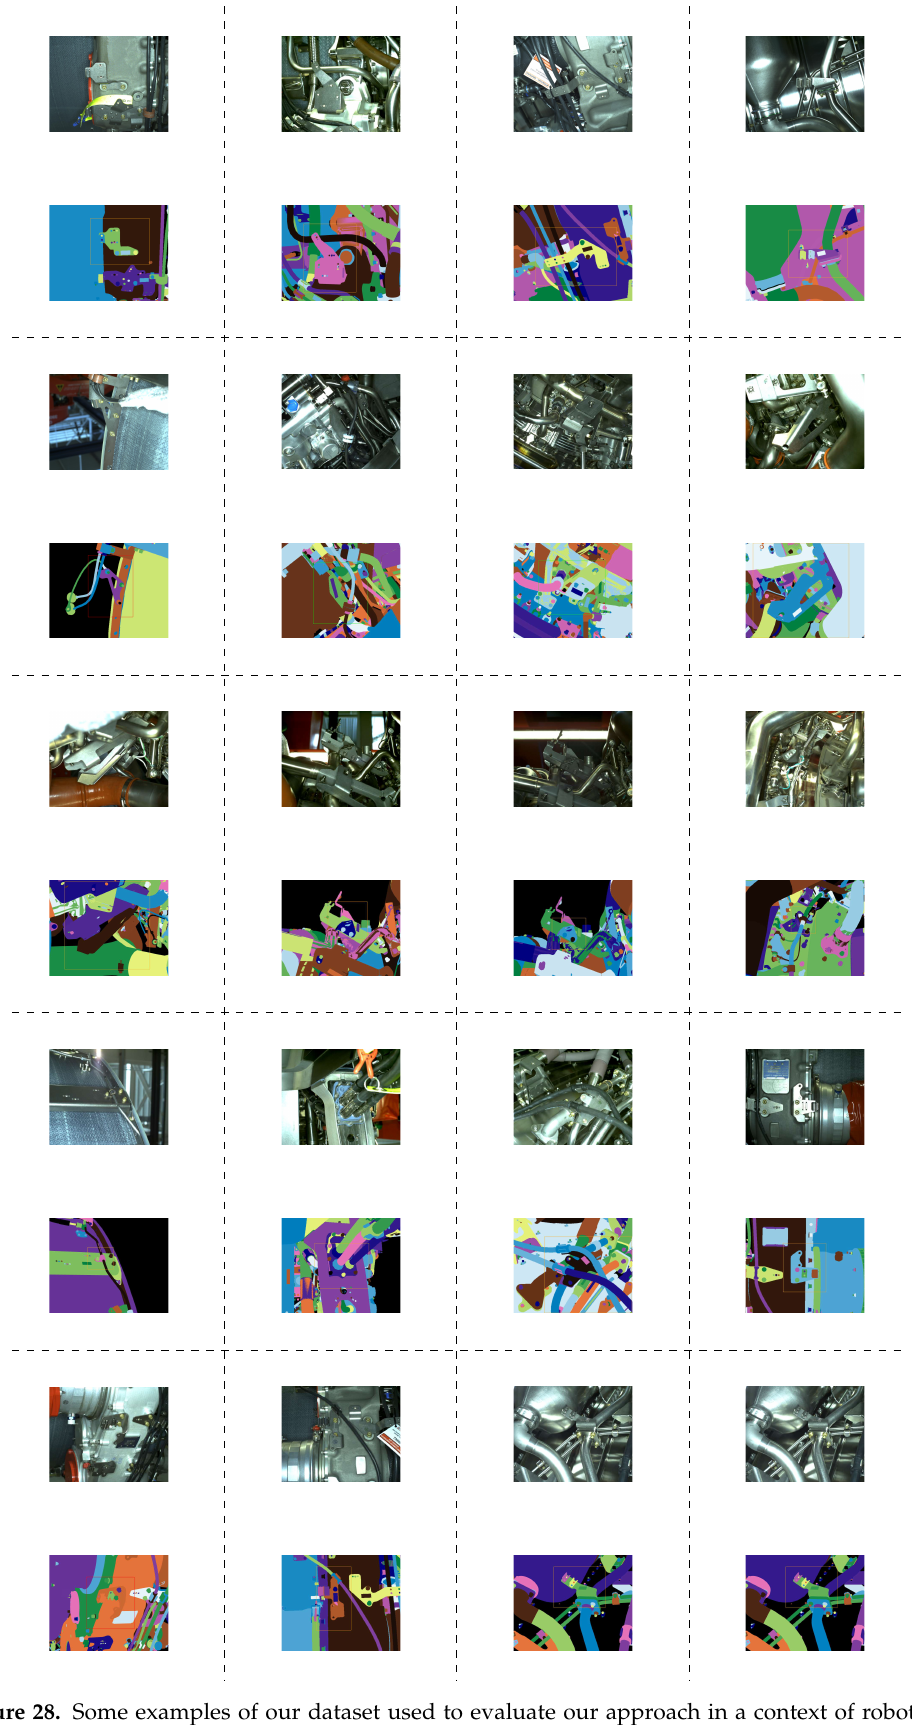
Figure 28. Some examples of our dataset used to evaluate our approach in a context of robotized inspection in conditions of very cluttered